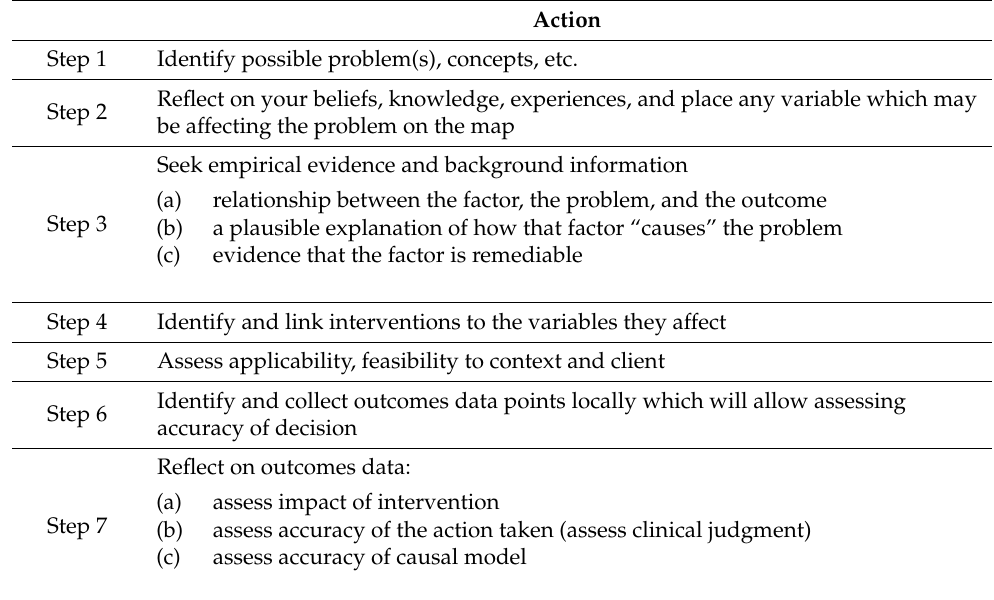
Table 1. Making thinking visible- Evidence-informed causal